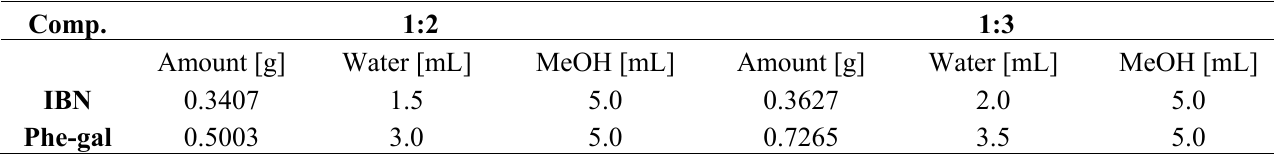
Table 4. Ibandronate (IBN) and phenyl- β - D -galactopyranoside (Ph-gal) in ratios 1:2 and 1:3 with addition of methanol (samples 4 - 7